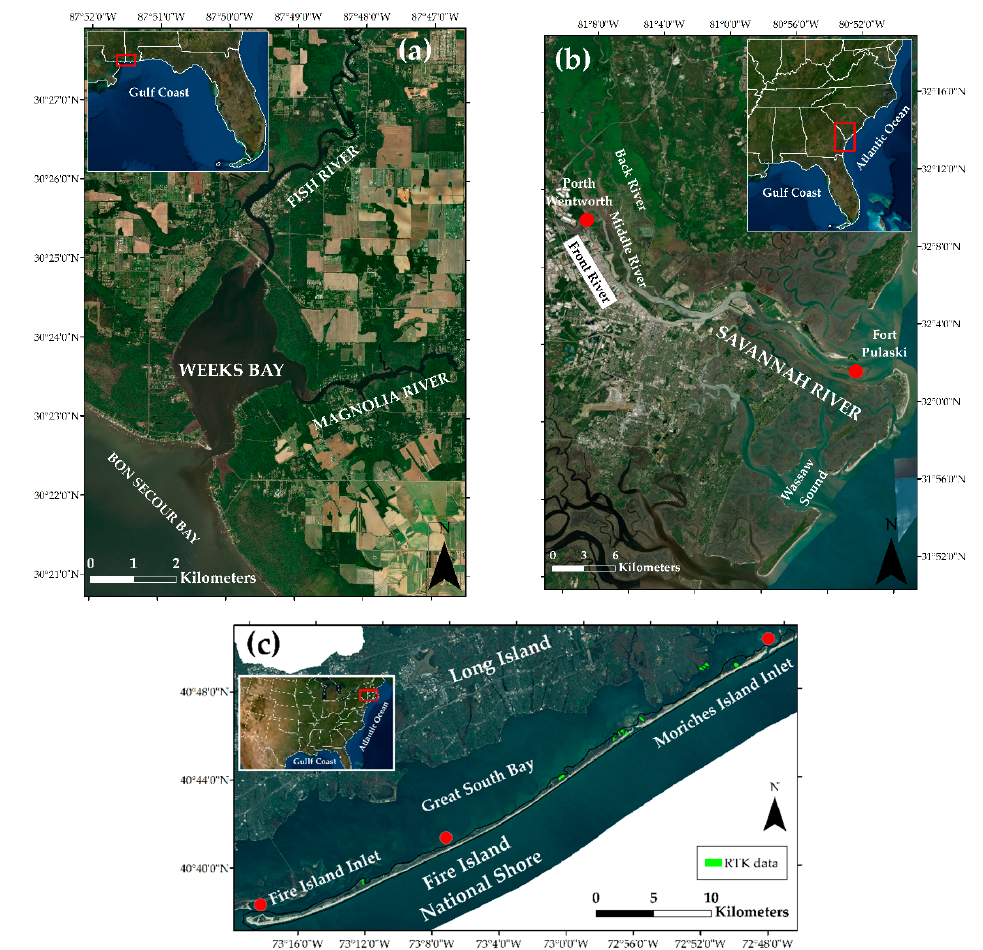
Figure 1. Map of the study areas and their location in the United States: ( a ) Weeks Bay, Alabama; ( b ) Savannah, Georgia; and ( c ) Fire Island, New